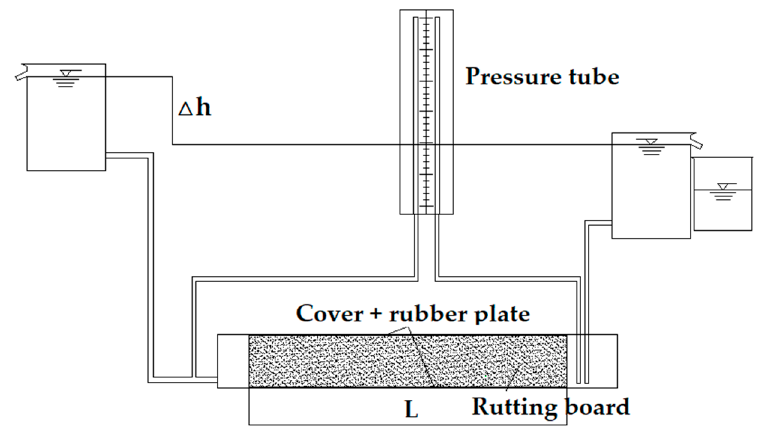
Figure 5. Transverse permeability tester for rutted slab.